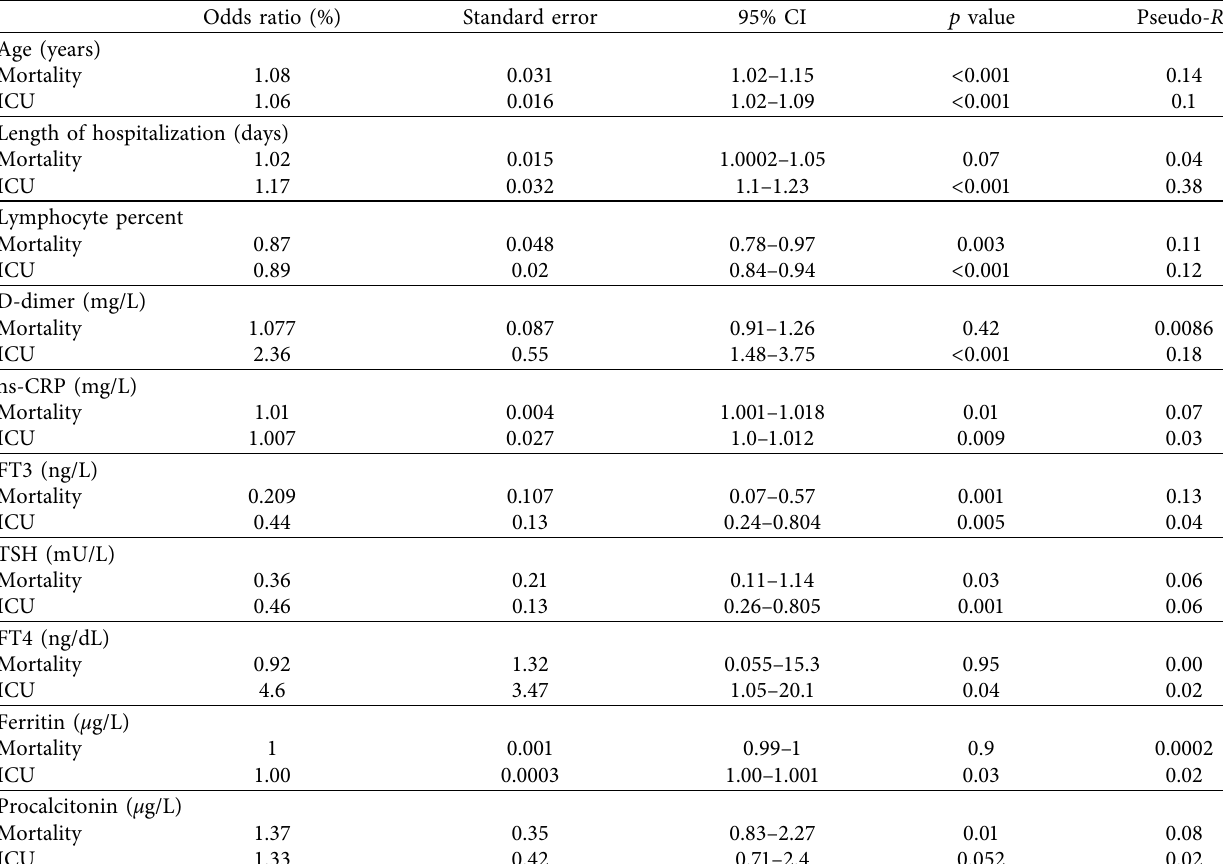
Table 6: Univariate logistic regression analysis of parameters associated with mortality and ICU